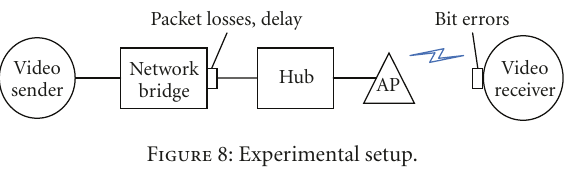
Figure 8: Experimental